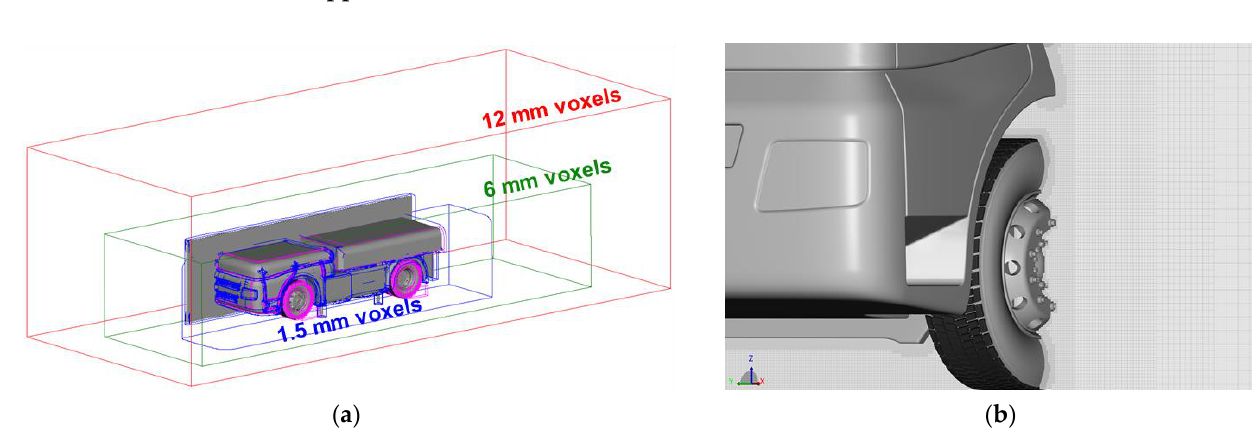
Figure A1. Volume discretization of the scale model: ( a ) Refinement regions with local voxel sizes of 12 mm, 6 mm, 1.5 mm, and offset regions with 0.375 mm resolution (pink); ( b ) Voxel grids for the cross section of the front wheel.